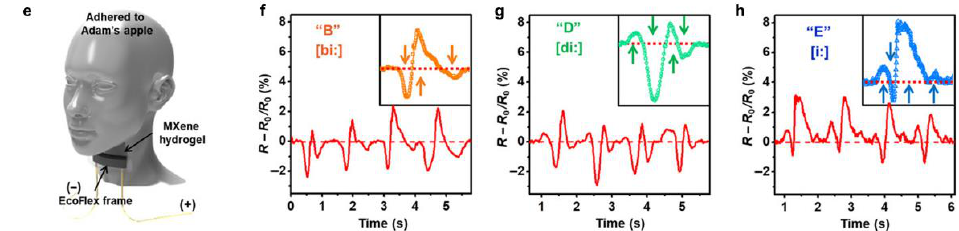
Figure 8. Advancement in strain sensors based on MXenes/PVA hydrogel: ( a ) schematical illustration of signature sensing; changed resistance to ( b ) signature; and ( c , d ) handwriting. ( e ) Schematical illustration of vocal sensing. ( f – h ) Changed resistance in responding to similar sounding letters (reprinted with permission from ref. [105]).